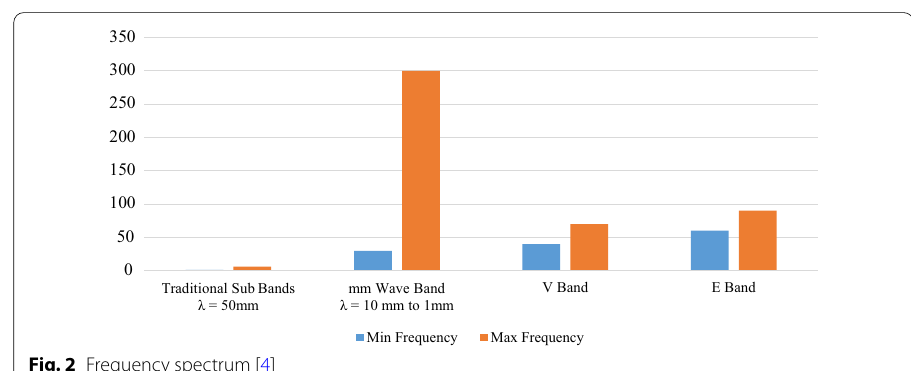
Fig. 2 Frequency spectrum